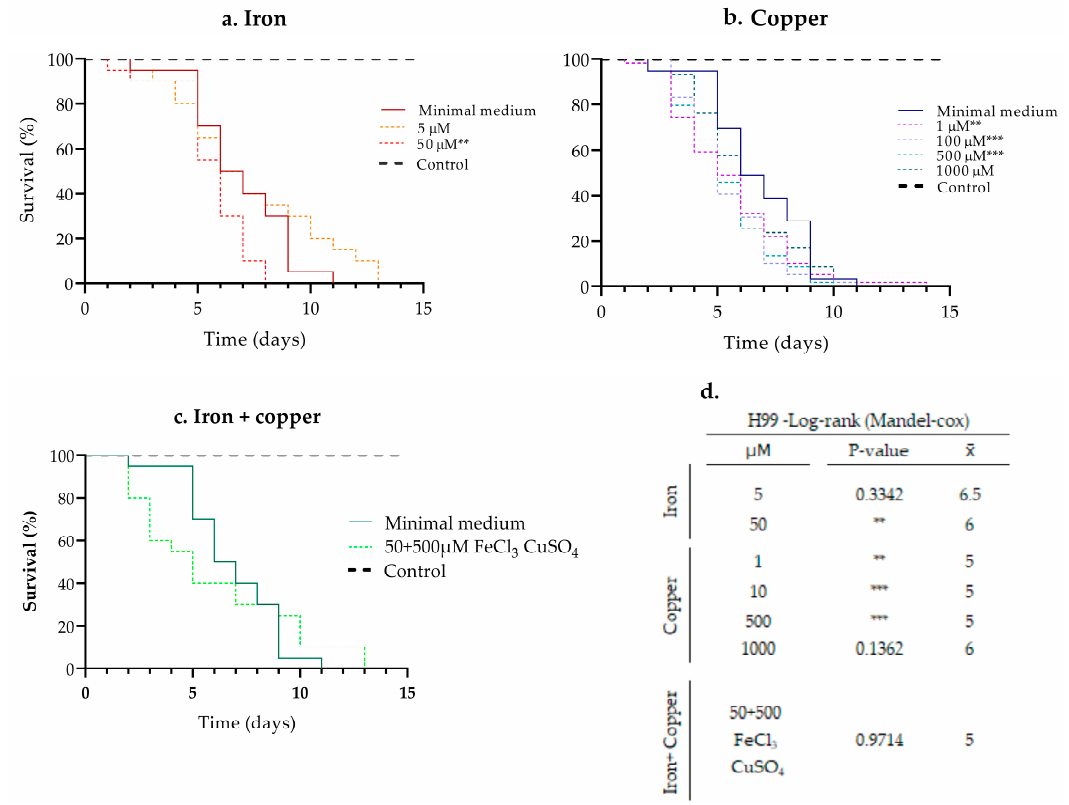
Figure 1. Effect of the pre-incubation with ( a ) iron, ( b ) copper, and ( c ) their combination on the pathogenicity of H99 in G. mellonella. ( d ) The table shows the results of the statistical test. p ≤ 0.01 (**); p ≤ 0.001 (***). The results correspond to three biological replicates; x : average mortality. The clinical isolates exhibited a different dynamic in the size of the capsule and cell body compared to the H99 strain. The capsule size in isolate 2807 was larger when 500 µ M copper (3.1 µ m) was used, compared to the basal condition (0.8 µ m). In isolate 3102, the capsule enlargement was greater after metal combination use (2.7 µ m), compared to the basal growth condition (0.9 µ m) (Figure